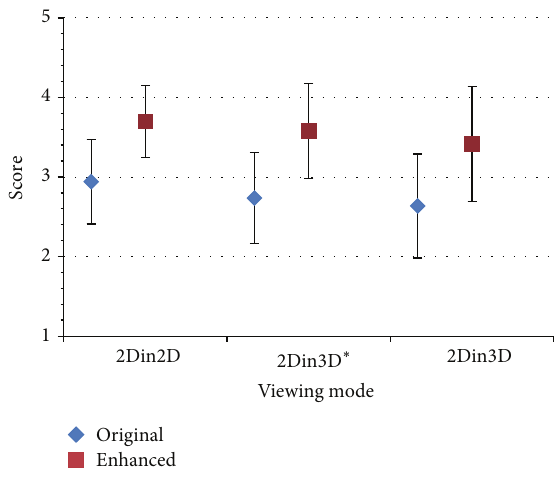
Figure 6: The mean scores and their respective 95% confidence intervals for the reduction of brightness and resolution are given for the original and enhanced